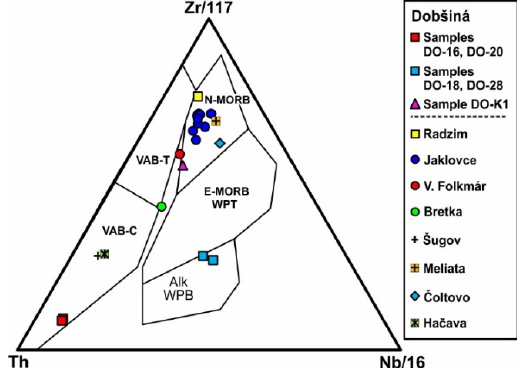
Figure 11. Zr/117–Th–Nb/16 discrimination diagram of [108] for the Meliatic metabasalts Three groups of basalts were distinguished: Calc ‐ alkaline, alkaline, and N ‐ MORB. Abbreviations; alkaline within ‐ plate basalts (Alk WPB), enriched mid ‐ ocean ridge basalts (E ‐ MORB), normal mid ‐ ocean ridge basalts (N ‐ MORB), calc ‐ alkaline volcanic arc basalts (VAB ‐ C), tholeiitic volcanic arc basalts (VAB ‐ T), and within plate tholeiites (WPT).